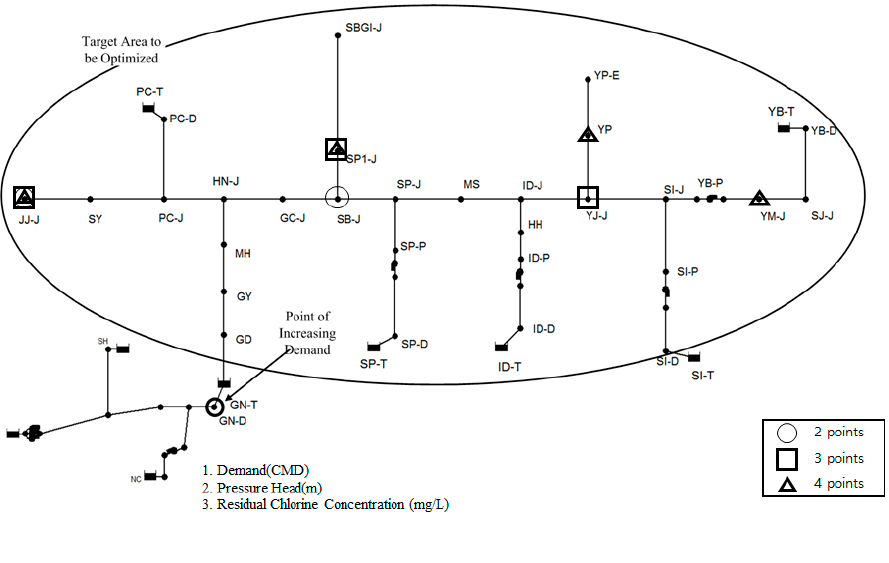
Figure 6. Optimal points in abnormal conditions.